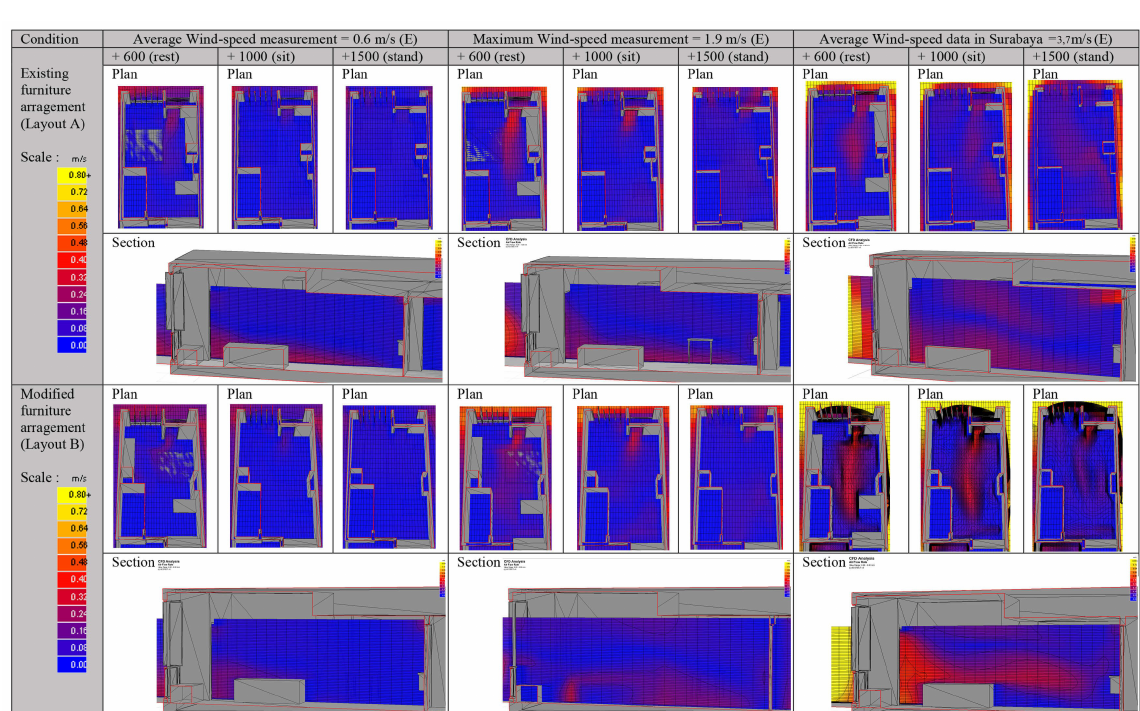
Fig. 2. Condition 0.